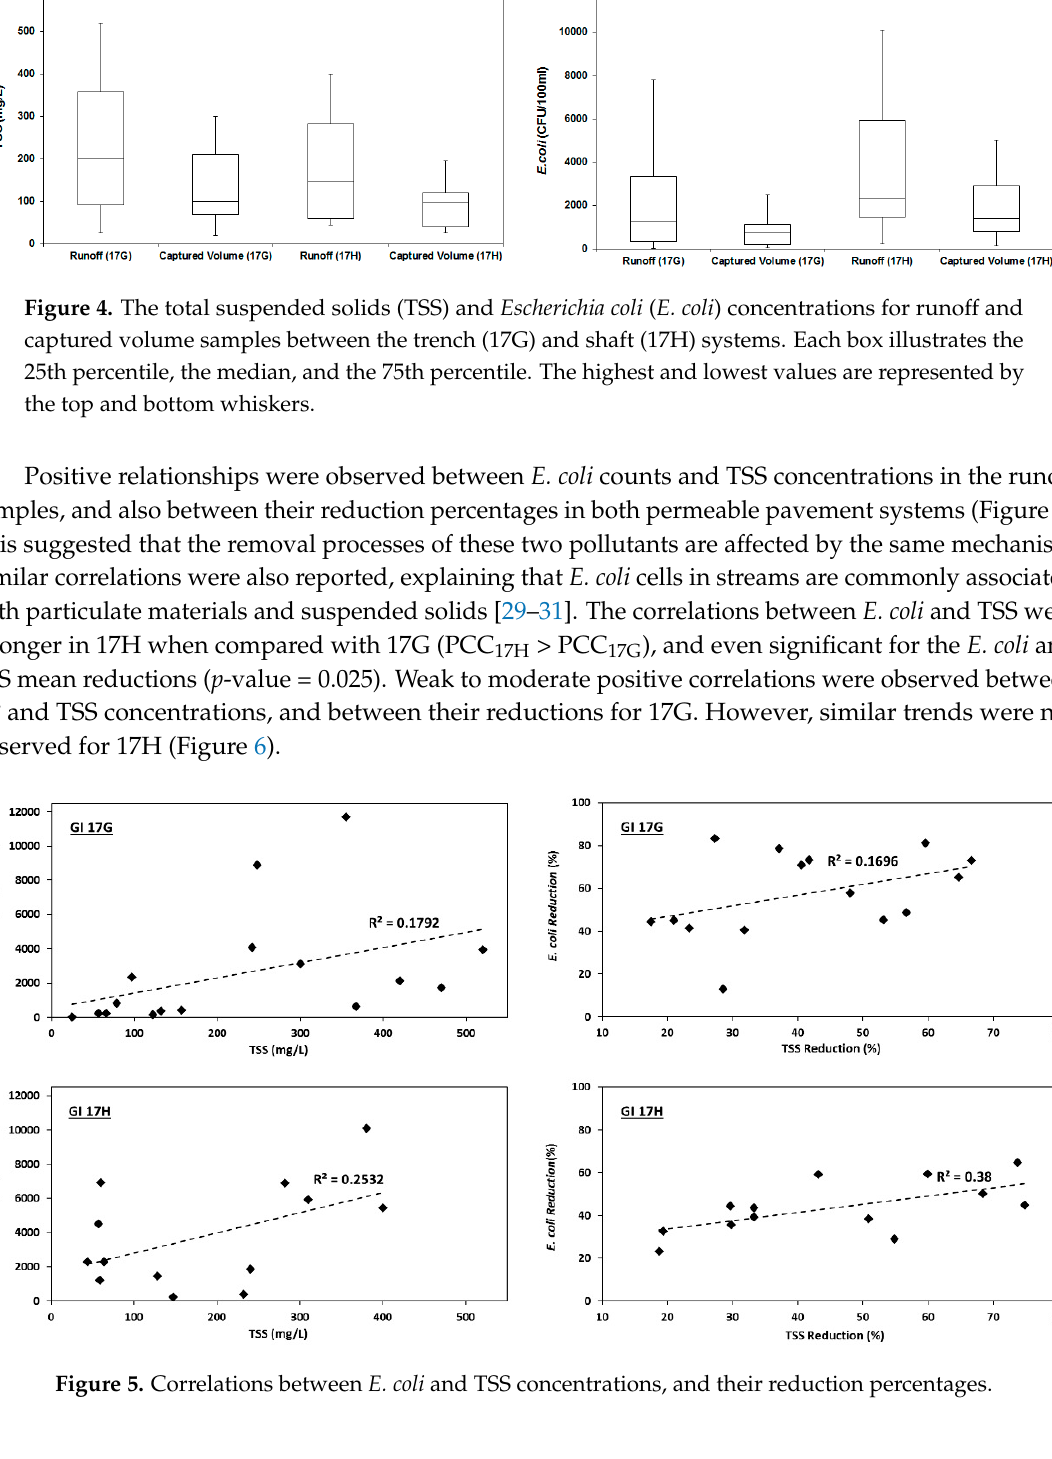
Figure 6. Correlations between total phosphorus (TP) and TSS concentrations, and their reduction percentages. 3.4. Effect of Rainfall Characteristics The relationships of E. coli and TSS concentrations in the runoff, and their reduction percentages, with rainfall characteristics (intensity and antecedent conditions), were also investigated. The